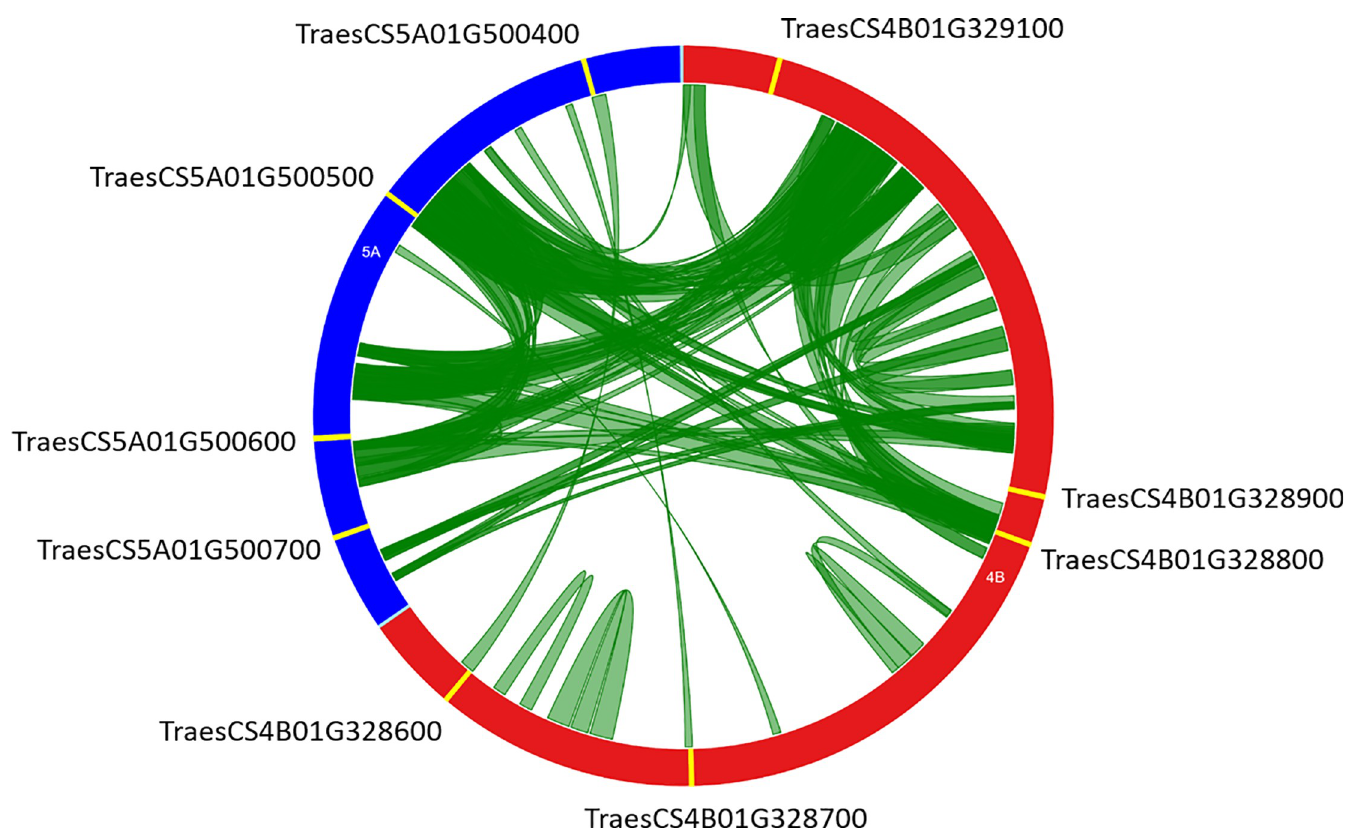
Fig 3. Circos diagram of chromosomes 4B (red, 396.990 Kb) and 5A (blue, 209.278 Kb) genomic regions containing nine TaNAC genes (yellow features). Green bands link two chromosomal regions with more than 80% of homology and a minimal length of 2